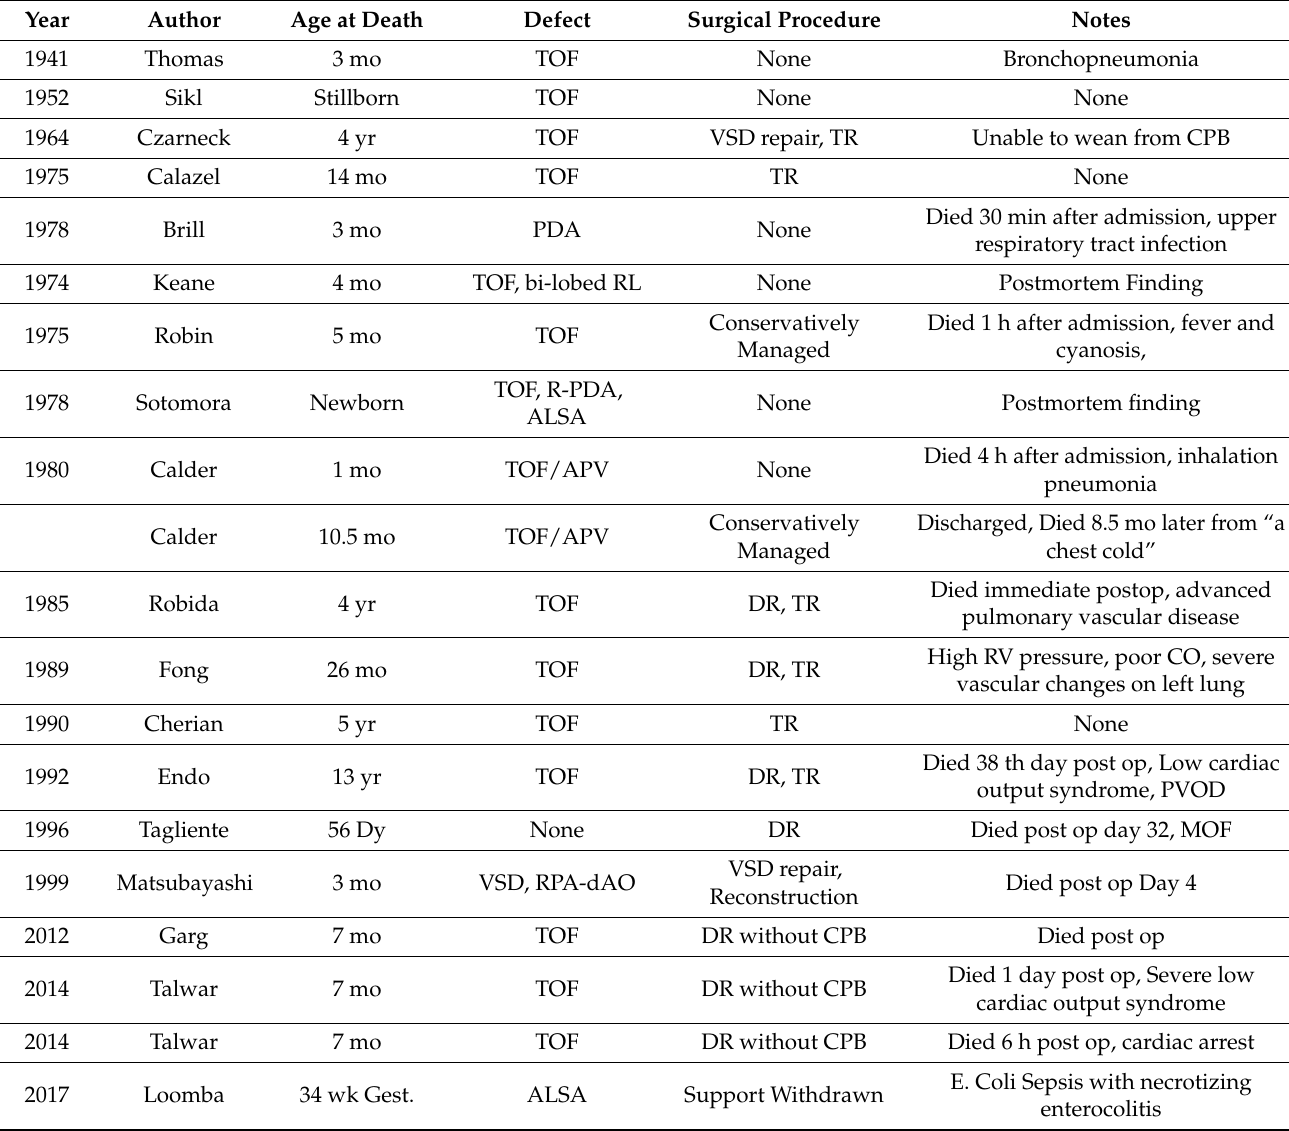
Table 3. Causes of mortality and age of death by case. AR(L)SA = Aberrant Right (Left) Subclavian Artery, CPB = Car- diopulmonary Bypass, DR = Direct Reimplantation, MOF = Multi-organ Failure, PAVSD = Pulmonary Atresia Ventricular Septal Defect, PDA = Patent Ductus Arteriosus, PVOD = Pulmonary Vascular Obstructive Disease, RL = Right Lung, TOF = Tetralogy of Fallot, TR = Tetralogy of Fallot repair, VSD = Ventricular Septal Defect. Dy = days, mo = months, yr = years, wk =